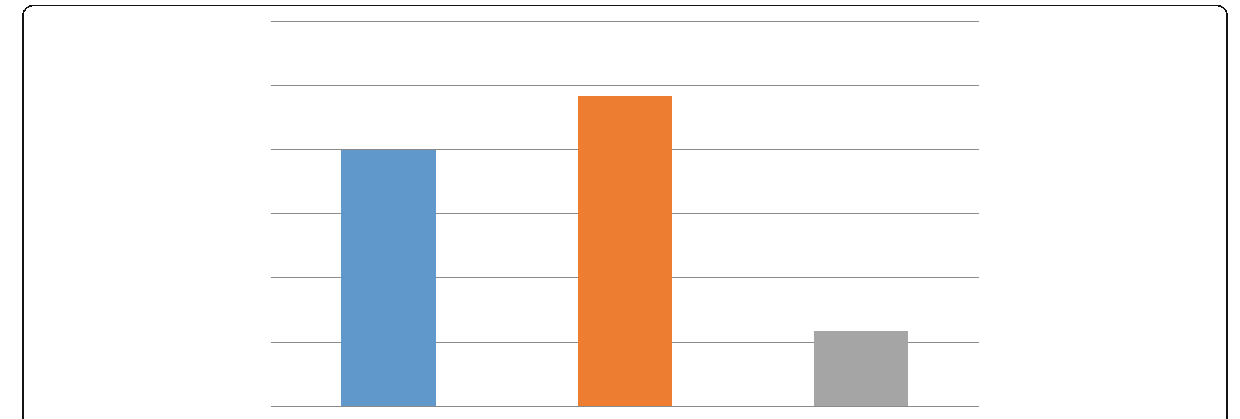
Fig. 3 Tomosynthesis outcome on the BIRADS